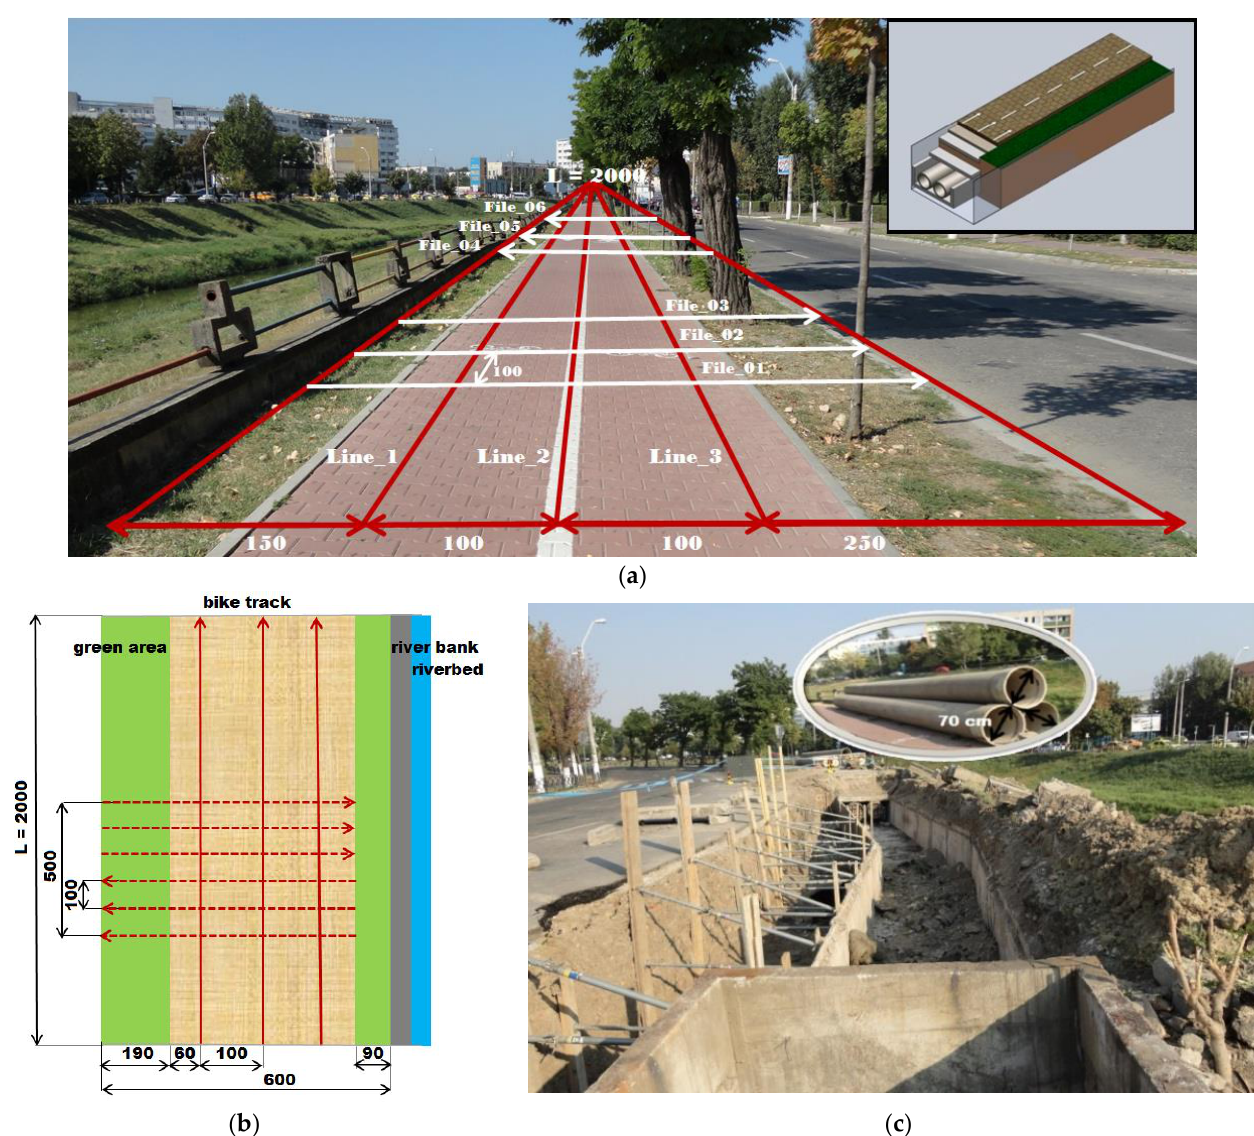
Figure 3. Surveyed zone: ( a ) the investigated region on both directions on drainage pipes (inset — configuration of the surveyed zone); ( b ) scanning scheme on both directions; ( c ) the region where the two urban drainage pipes should be repaired or replaced (inset-pipes to be replaced); ( c ) picture was taken several days after GPR surveying); (all dimensions are in cm).